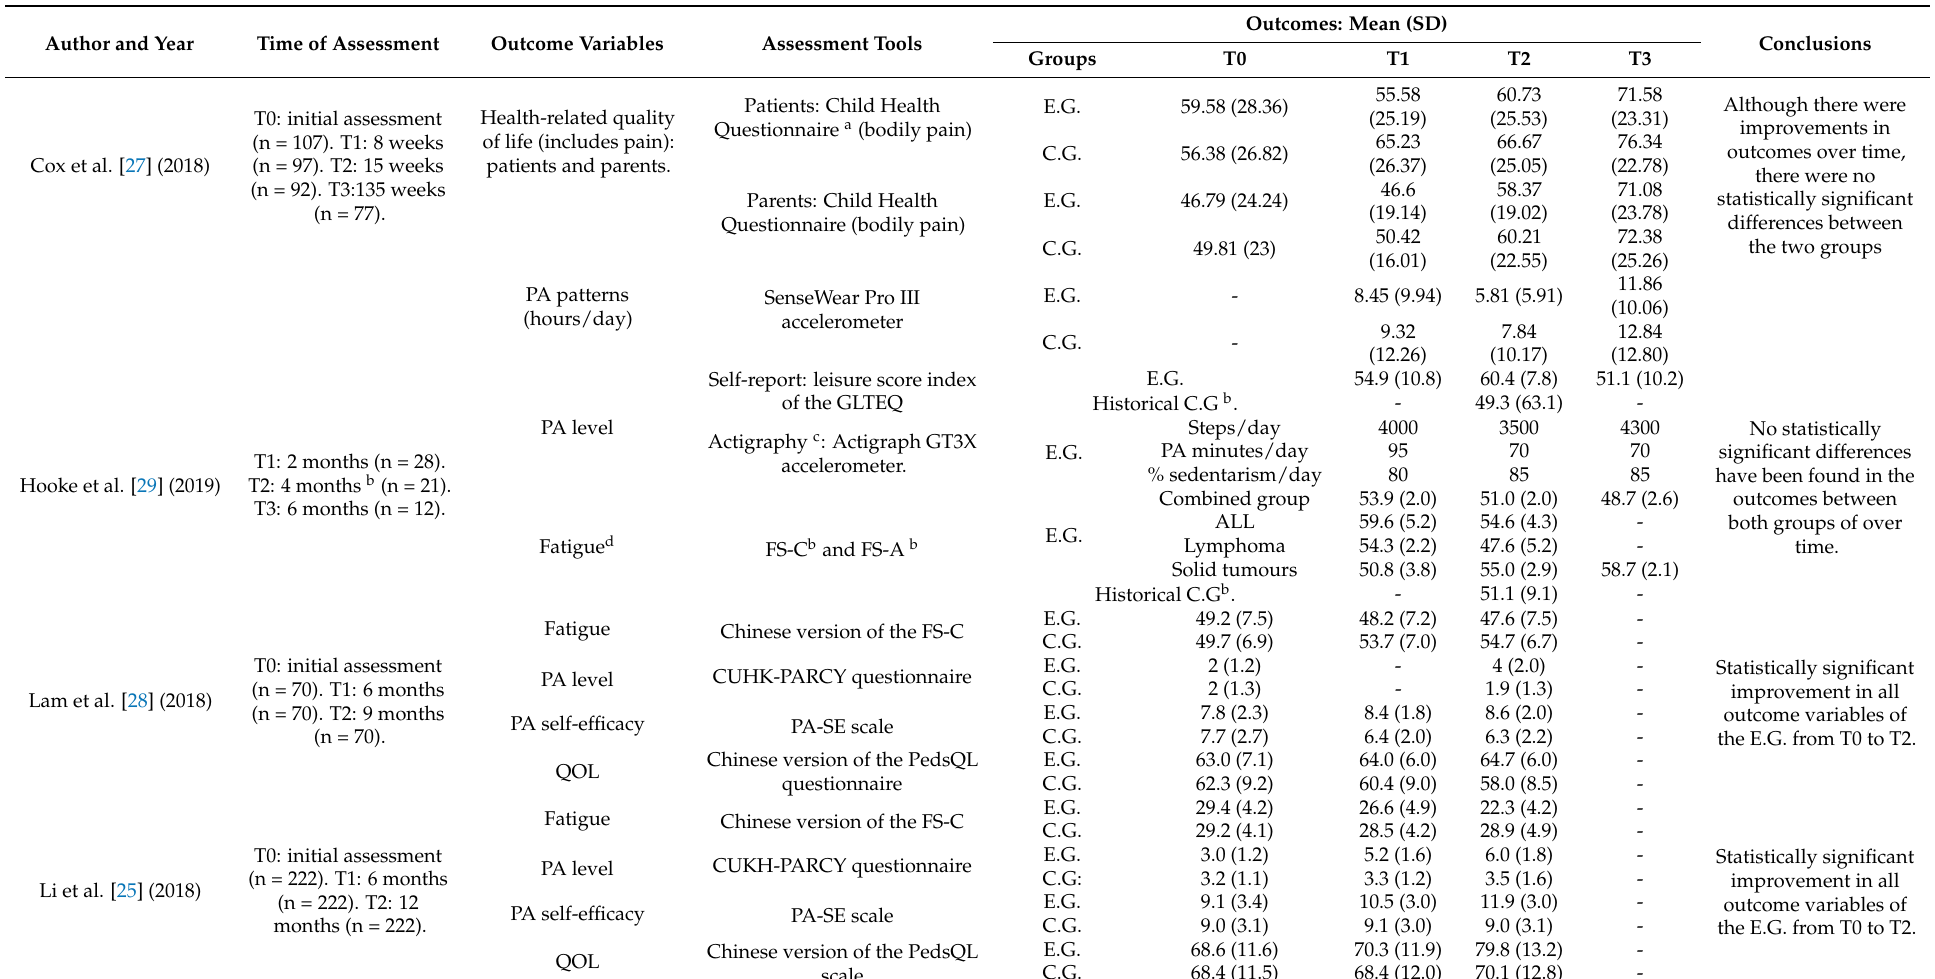
Table 2. Outcome measures of the analysed